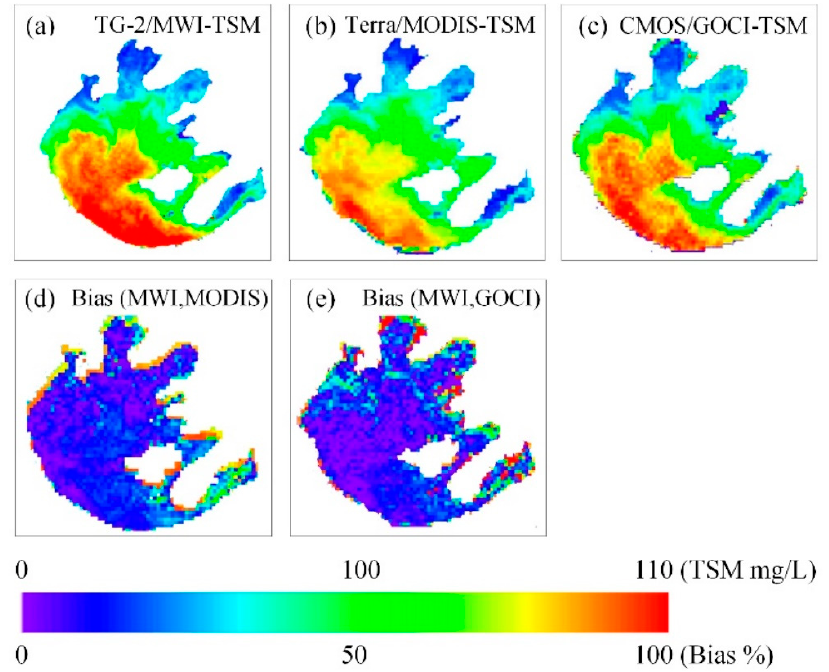
Figure 11 . Maps of the total suspended matter (TSM) products derived from ( a ) TG ‐ 2/MWI, ( b ) Terra/MODIS and ( c ) CMOS/GOCI data on 14 March 2017. Biases of TSM derived from ( d ) TG ‐ 2/MWI and Terra/MODIS (Bias(MWI, MODIS)), and ( e ) TG ‐ 2/MWI and CMOS/GOCI (Bias(MWI,GOCI)) are displayed in the second row.